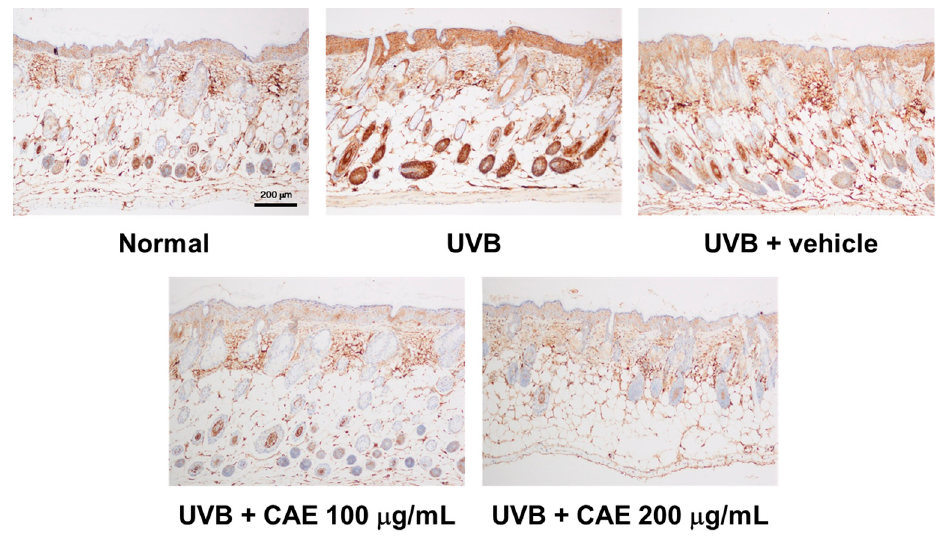
Figure 19. Immunohistological staining for IL-6 in the hairless mouse skin after UVB exposure and CAE treatment.